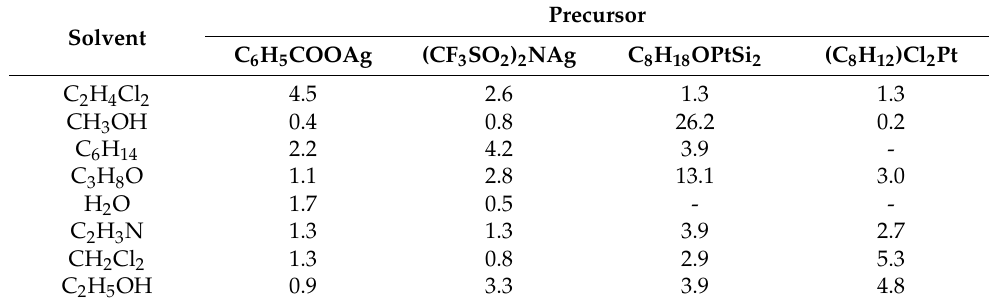
Table 1. Concentrations (mM) of precursors in solutions used for laser-induced deposition